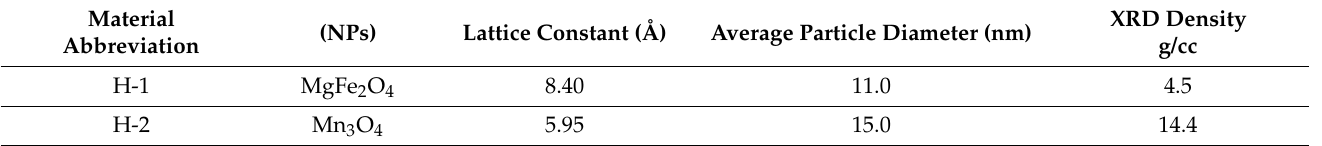
Figure 1. X-ray diffraction patterns of H-1, H-2, H-3 and H-4 NPs. Table 1. XRD Parameters of